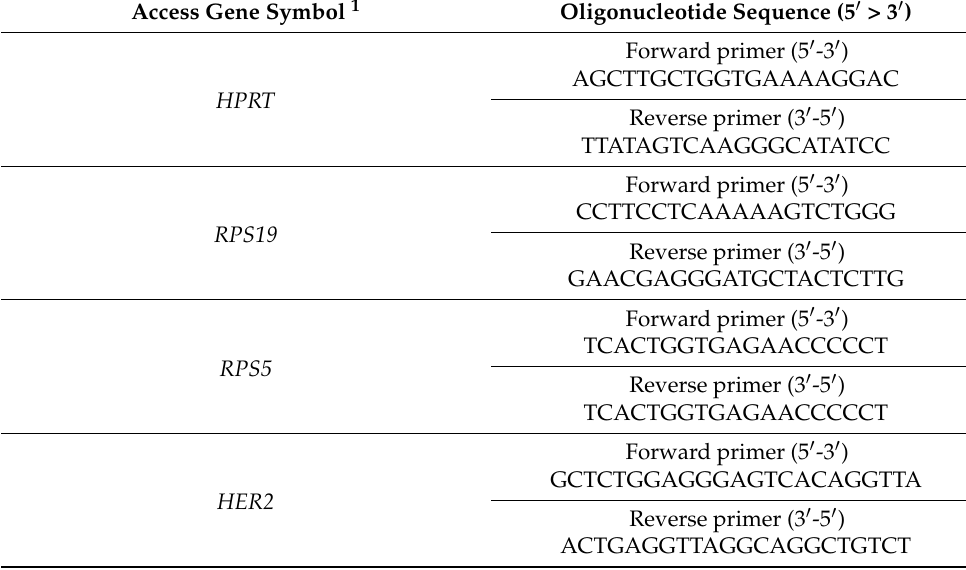
Table 2. Oligonucleotide sequences of the primers used for